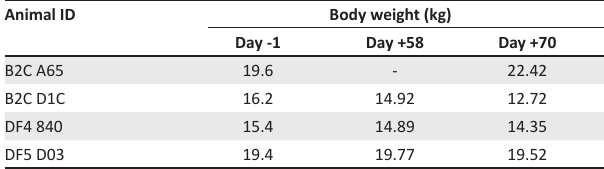
TABLE 3: Body weights, as recorded over the study period.